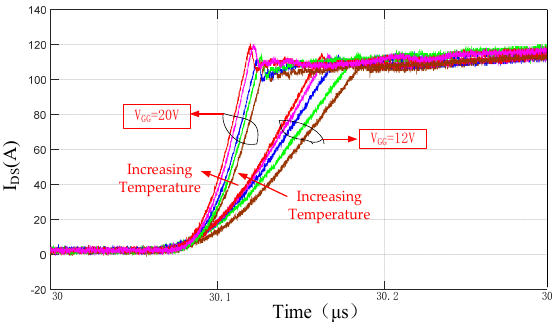
Figure 13. Different temperature drain current waveforms for two drive voltages.